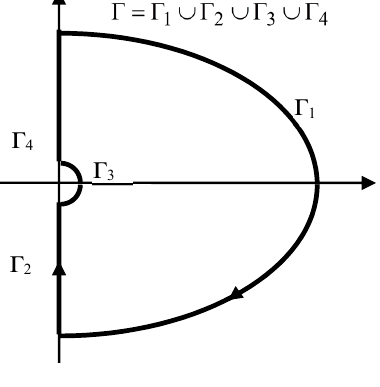
Figure 9. Considered path Г .